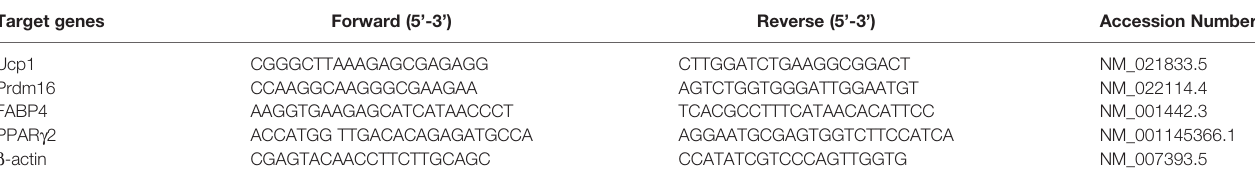
TABLE 1 | Primer sequences for the quantitative reverse-transcription polymerase chain reaction. Target